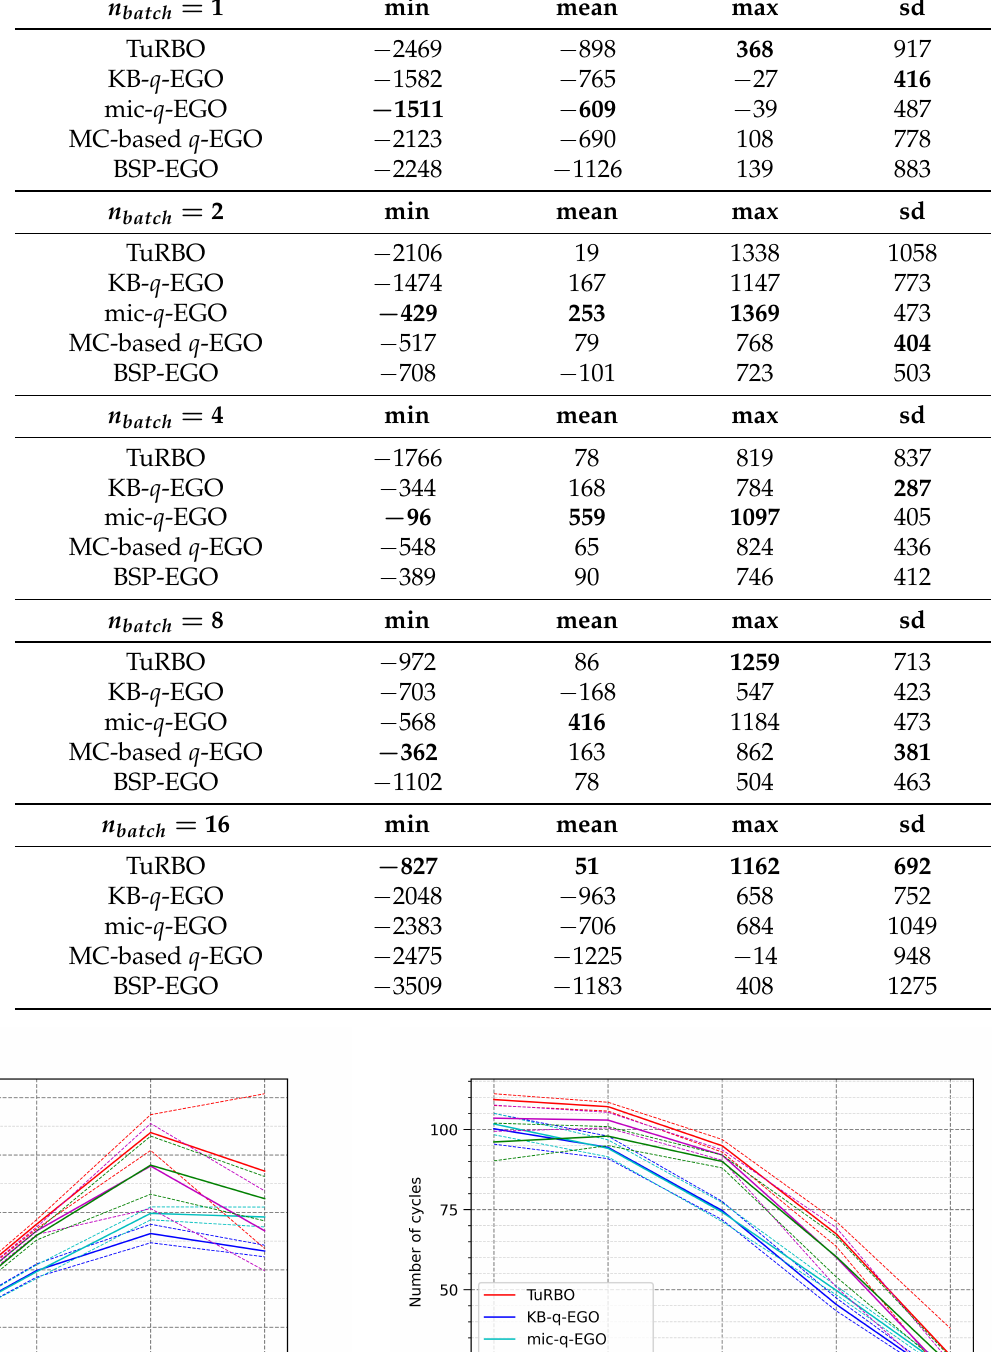
Table 7. Minimum, maximum, average profit values (EUR) as well as standard deviation of the UPHES management problem obtained with 10 runs of each method according to batch size.